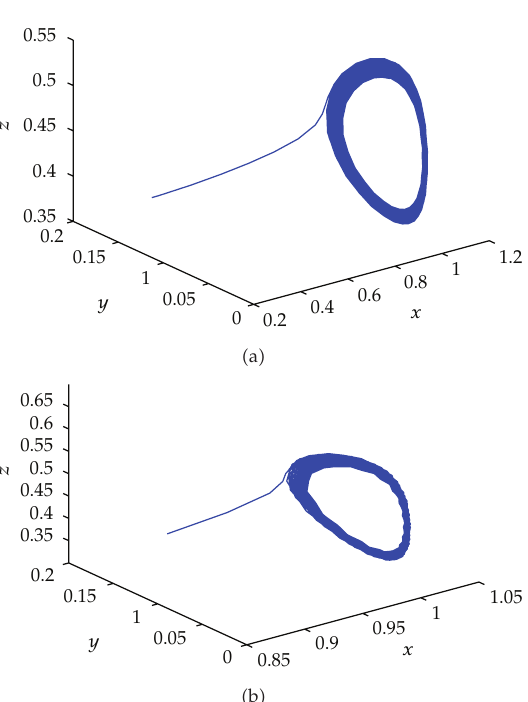
Figure 4: The stable periodic orbits of system (cid:6) 2.2 (cid:7) when τ (cid:8) 200 . 7288 and τ (cid:8) 400 . 8768 with parameters given by (cid:6) 3 (cid:7)